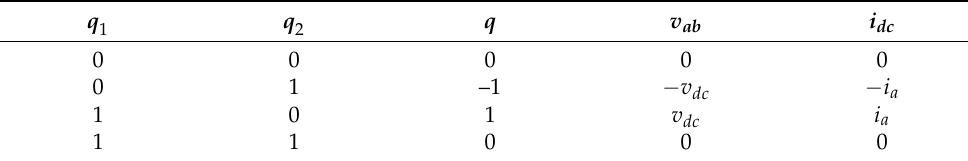
Table 1. Definition of the switching functions.